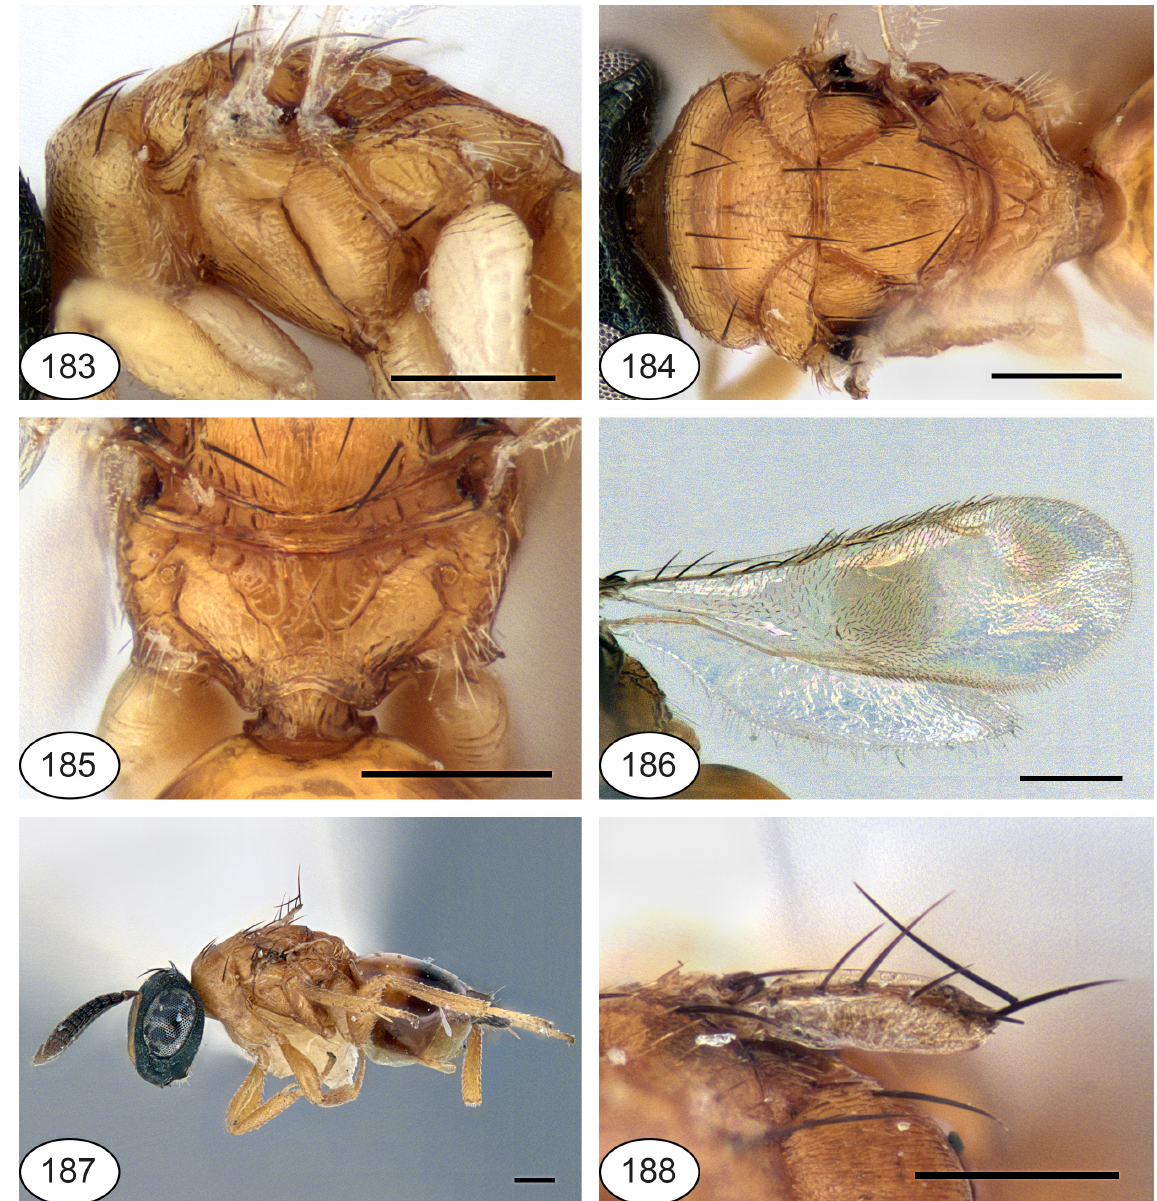
Figs 183–188. Netomocera setifera Bouček, 1954. 183 . ♀, Romania, mesosoma, lateral view. 184 . ♀, Romania, mesosoma, dorsal view. 185 . ♀, Romania, propodeum, dorsal view. 186 . ♀, Romania, fore and hind wings. 187 . ♀, Czech Republic, habitus, lateral view. 188 . ♀, Czech Republic, fore wing. Scale bars: 0.2